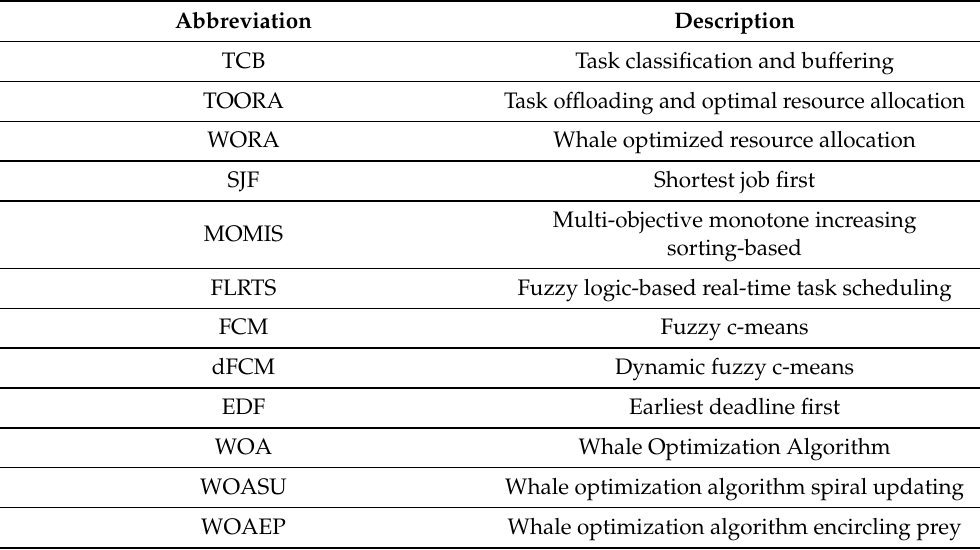
Table 2. Abbreviations and description.